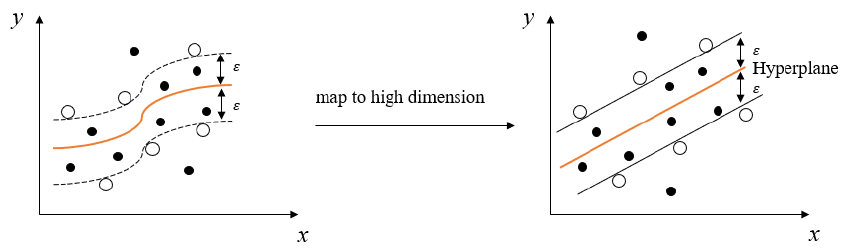
Figure 3. Structure of support vector regression.